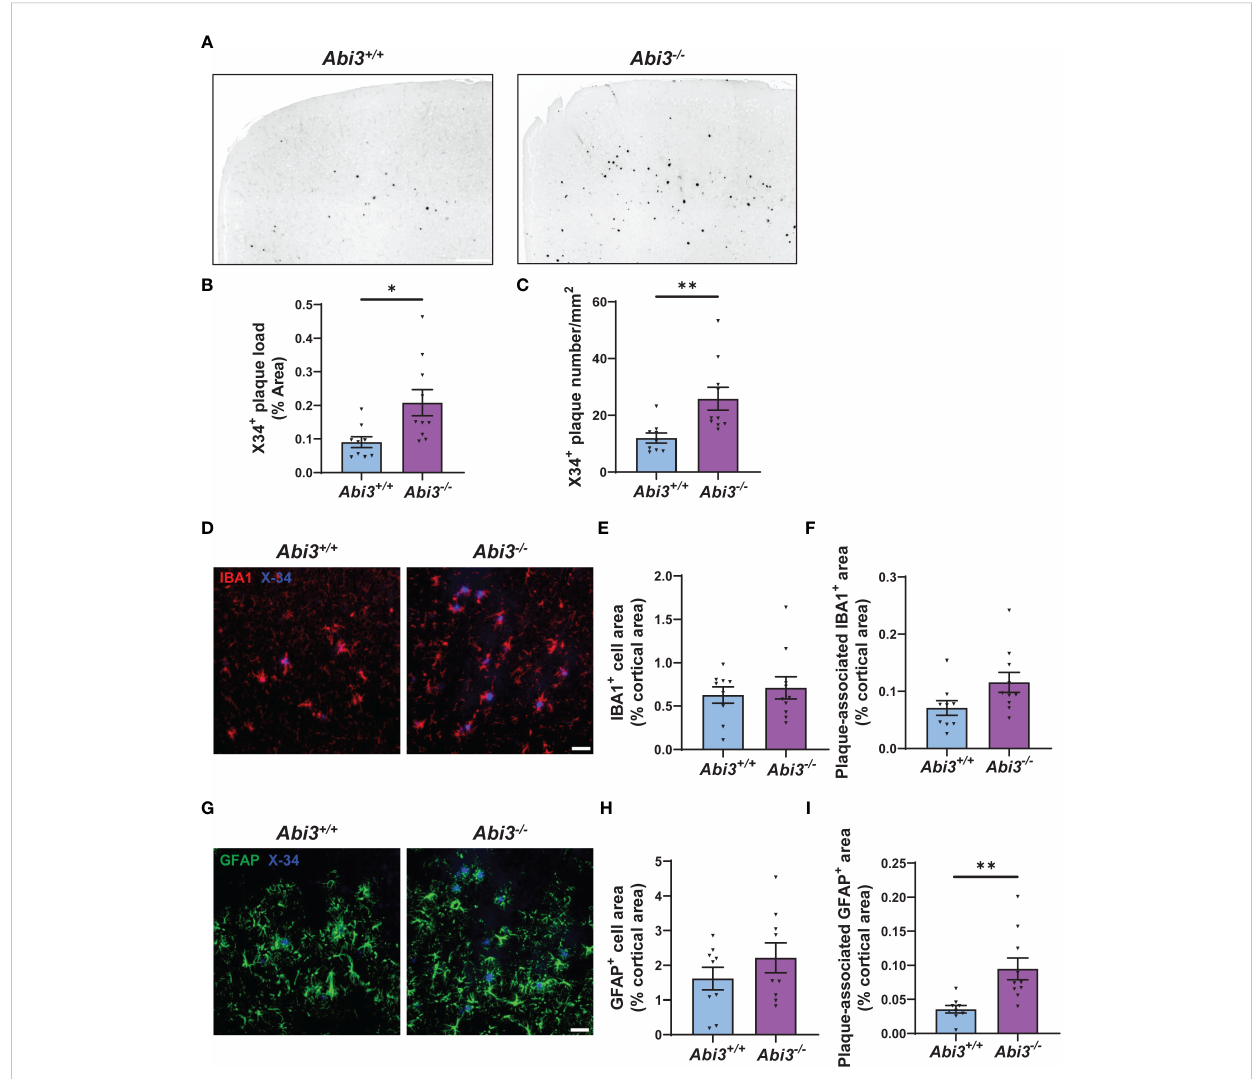
FIGURE 2 Deletion of the Abi3 gene locus increases amyloid plaques without altering gliosis in 5XFAD mice. (A) Representative images showing coronal brain sections from 4.5-month-old Abi3 +/+ and Abi3 -/- mice stained with X34 dye, which detects fi brillar plaques (Scale bar; 250 m m). Black stain indicates X34+ amyloid plaques. (B) Quanti fi cation of X34+ fi brillar plaque area and (C) the number of plaques in mouse cortices. (D) Representative images showing coronal brain sections stained with X34 dye and the microglial marker IBA1 antibody (Scale bar; 50 m m). (E) Quanti fi cation of IBA1+ area and (F) the area covered by IBA1 staining colocalized with X34+ plaques. (G) Representative images showing coronal brain sections stained with X34 dye and the astrocyte marker GFAP antibody (Scale bar; 50 m m). (H) The percent of the area covered by GFAP staining was quanti fi ed in the cortices of mice. (I) Quanti fi cation of GFAP+ area colocalized with X34+ plaques. Data represent mean ± SEM (n=9-10). Unpaired two-tailed t-test; * p < 0.05, ** p < 0.01. See also Supplementary Figure